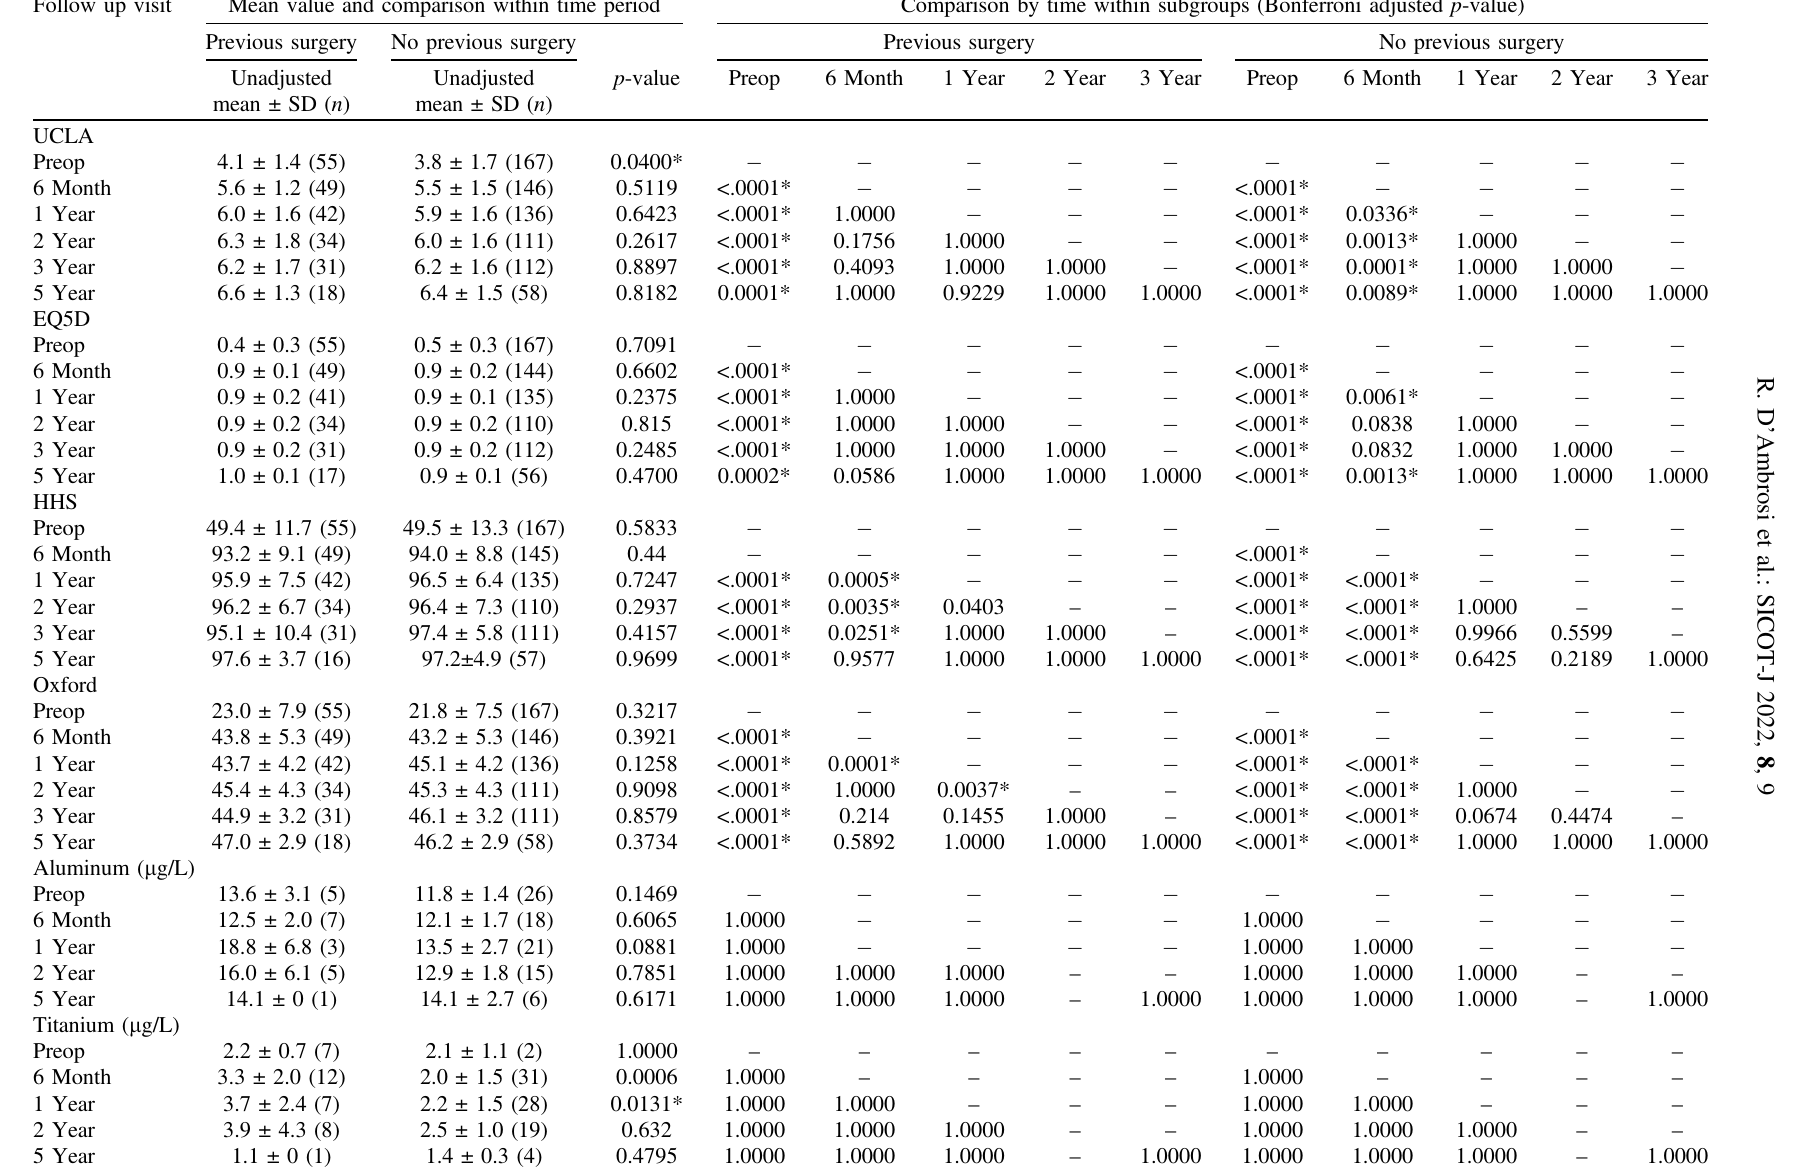
Table A.11. Group analysis by previous surgery. Follow up